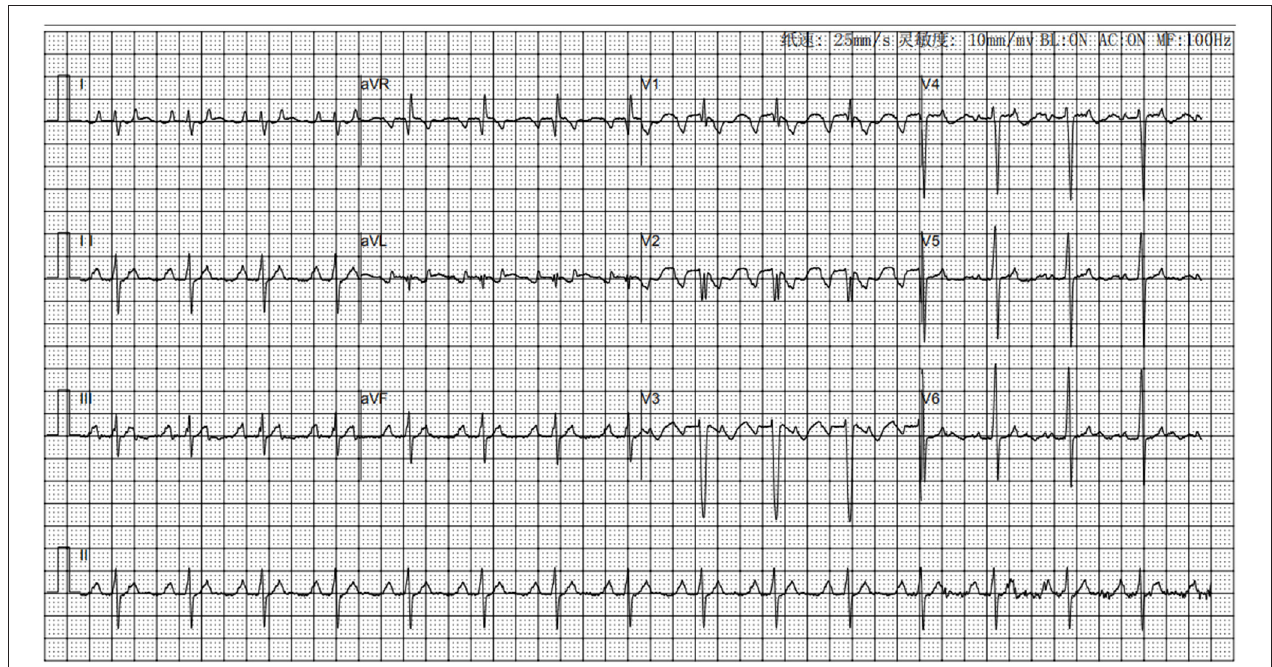
FIGURE 1 | The surface electrocardiogram during the onset of atrial